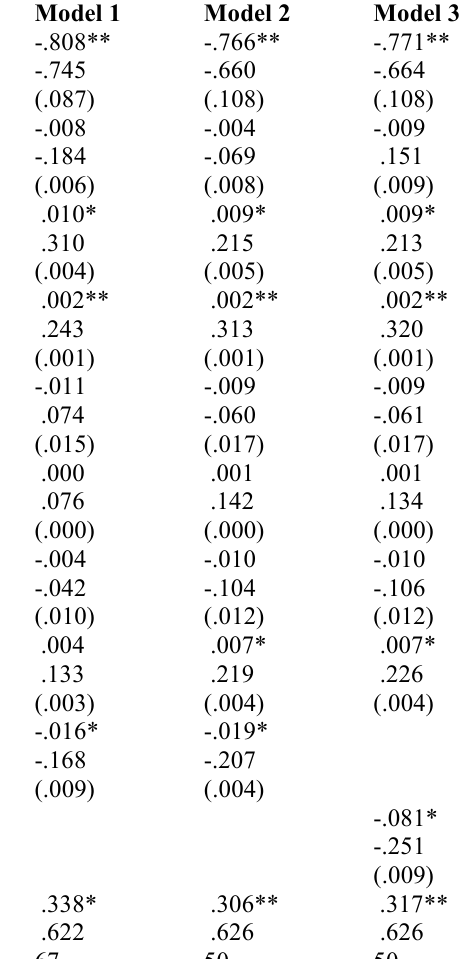
Table 2: Unstandardized Coefficients from the Regression of Labor Force/Pop Growth 1990-2003 on Military Expenditures per Soldier and Other Independent Variables in 1990: All Countries (Model 1) and Less Developed Countries Only (Models 2 and